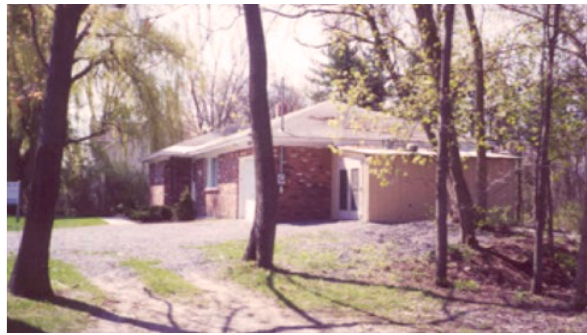
Figure 15. Plug Power house with PEM fuel cell in attached enclo- sure, 2001. Smithsonian